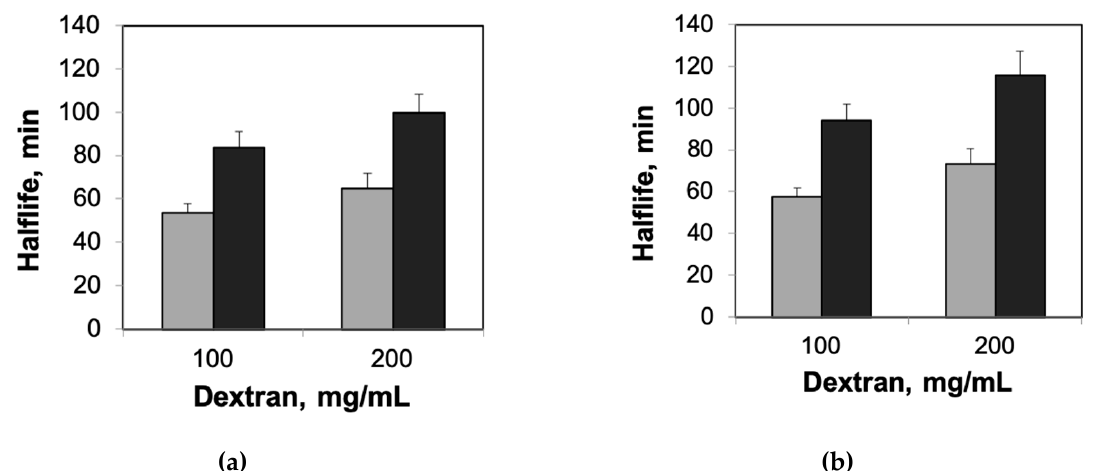
Figure 3. Thermal stability of enzymes encapsulated in agarose–dextran hybrid gels. Estimated half-lives of enzymes encapsulated in 0.5% agarose (gray bars) and 2% agarose (black bars) gels incorporating 100 mg / mL and 200 mg / mL dextran at elevated temperatures. ( a ) HRP and ( b ) β -gal. Error bars indicate the standard deviation of triplicate measurements. Table 1. Percent increase in half-lives of enzymes encapsulated in agarose–dextran a hybrid gels (prepared using ~500 kDa dextran) relative to solution-phase enzymes.